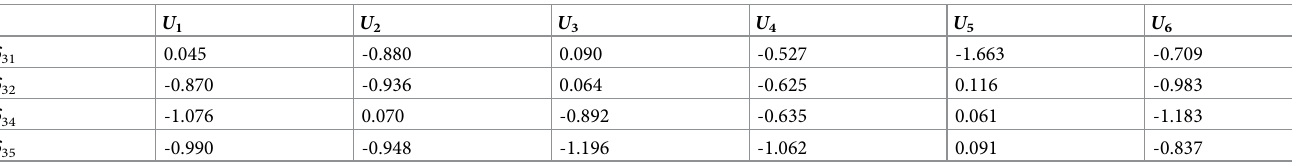
Table 26. The dominance of O 3 to others.